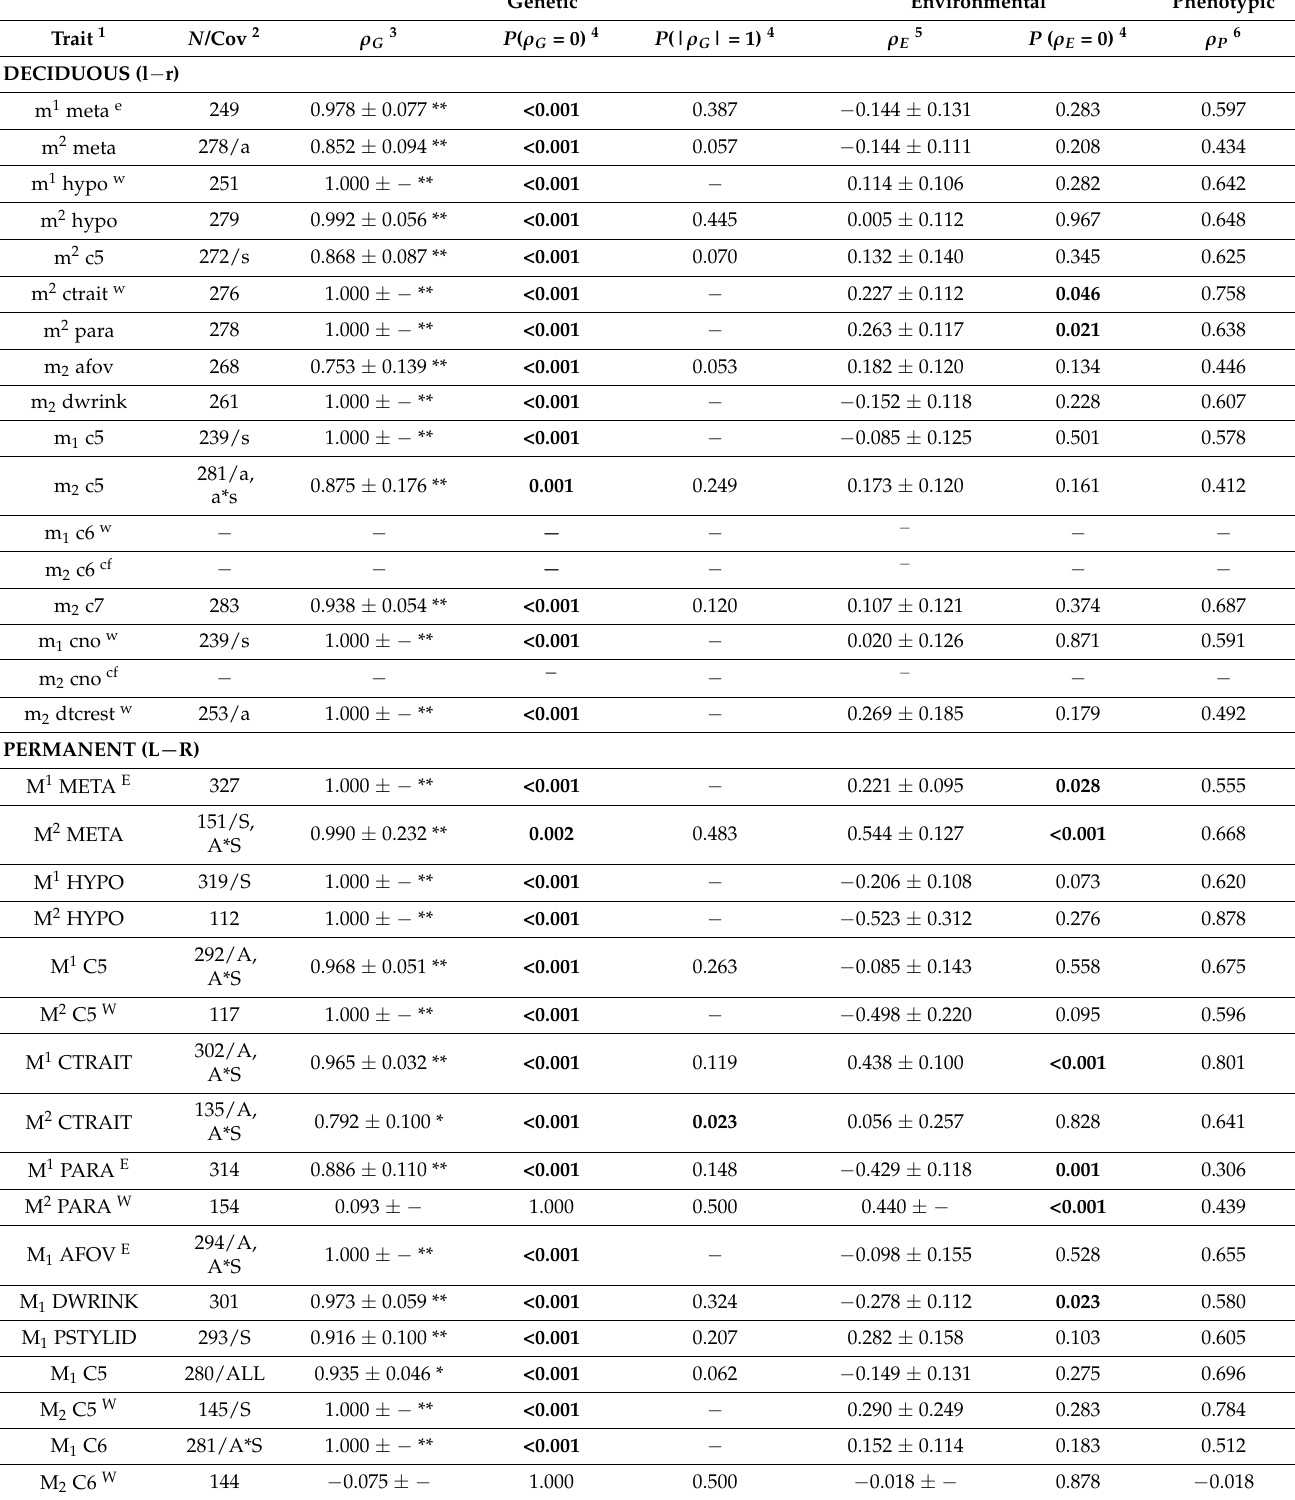
Table 2. Antimeric variance component